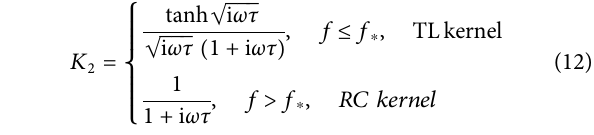
Frontiers in Energy Research |